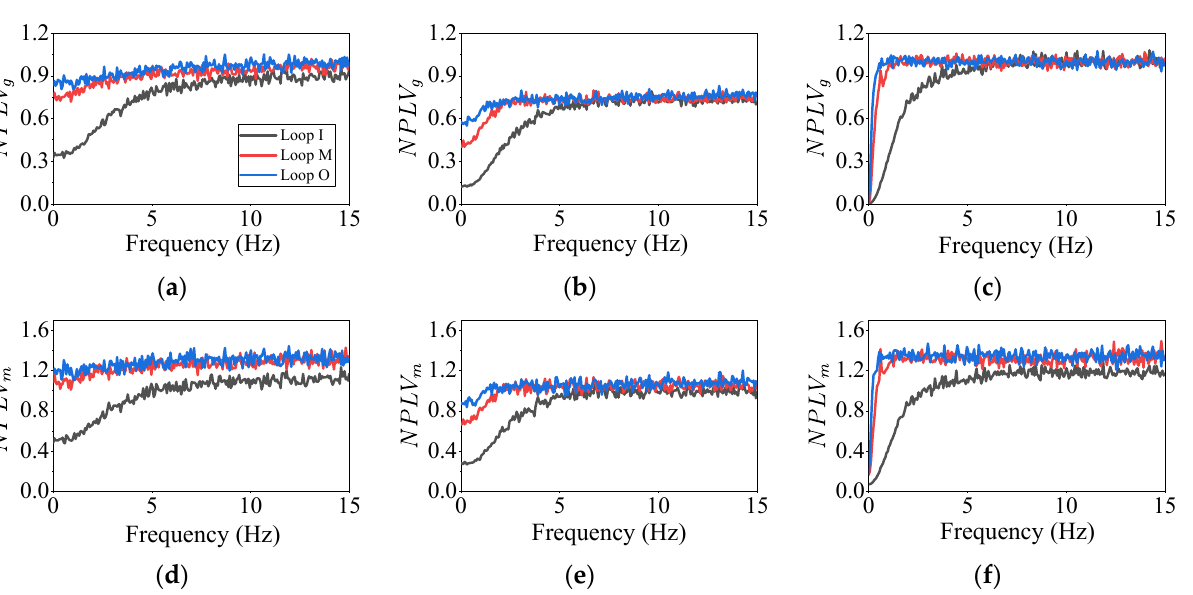
Figure 11. Coherence of ζ s estimated by different spectral coherence models γ lj : ( a ) N ζ = 6 and ( b ) N ζ = 12.